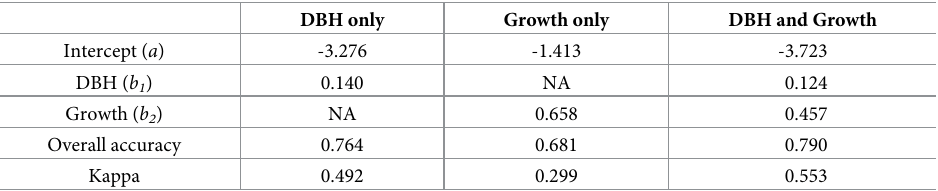
Table 1. Model coefficients and fit statistics for logistic regressions and associated classifications of canopy status of individual trees based on DBH, growth (MAI) or both